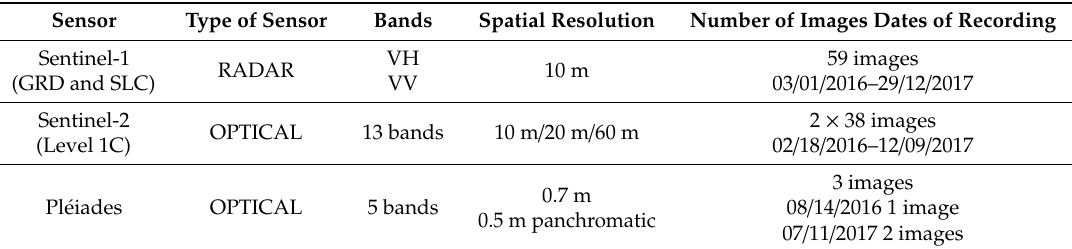
Table 1. Data set available.